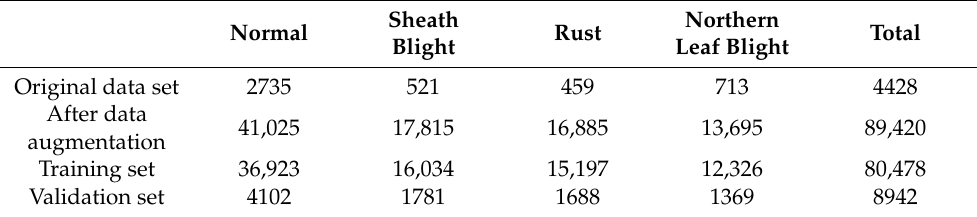
Table 1. Distribution of